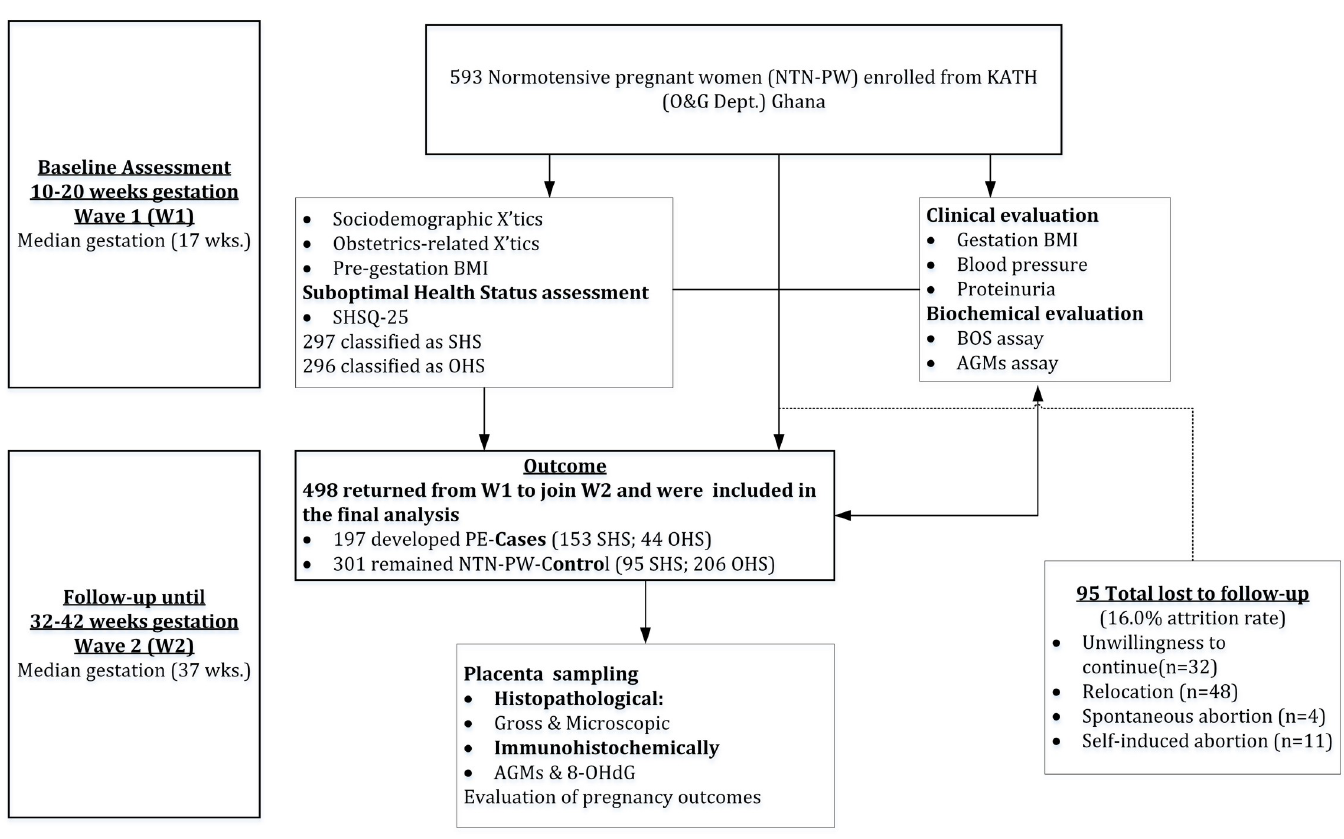
Fig 1. Flowchart of study